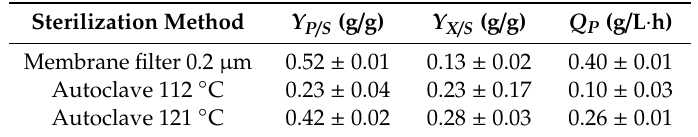
Table 4. Fermentation parameters obtained for the production of itaconic acid by A. terreus from cellulose pulp hydrolysate sterilized by different methods. 276